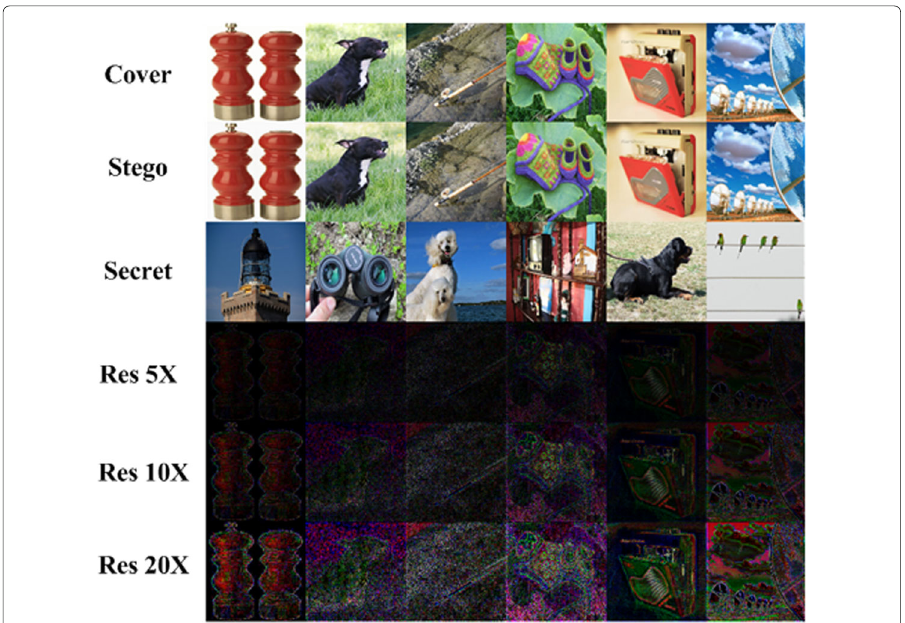
Fig. 5 The residual steganographic images generated by Duan’s model. The first three rows are the cover images, the corresponding steganographic images generated by Duan’s model, and the secret images; the last three rows are the residual images obtained by subtracting the pixel values of the steganographic images and corresponding cover images with 5 × , 10 × , and 20 × enhancement